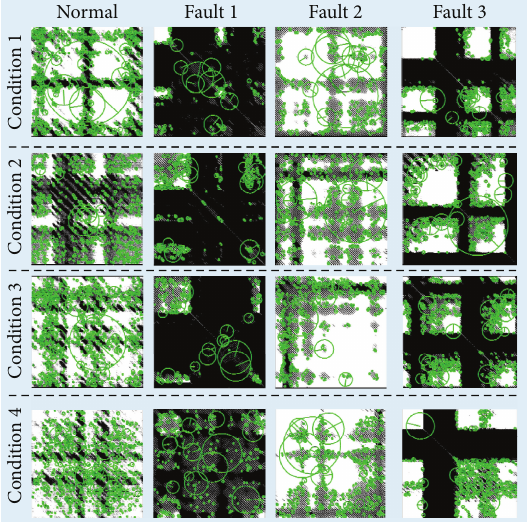
Figure 13: The detected interest points in RPs.